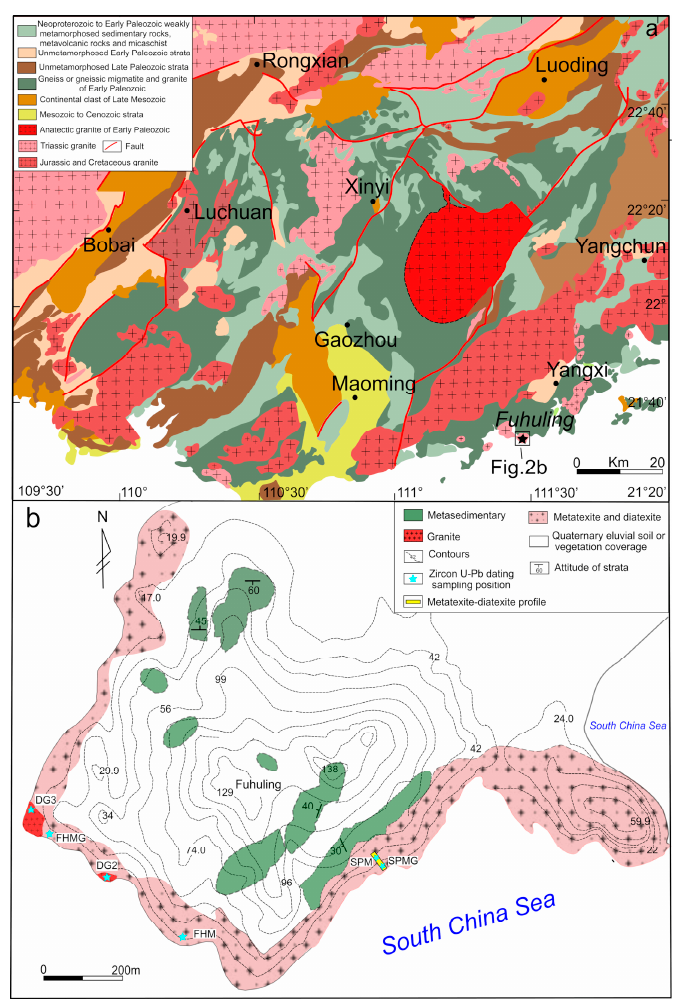
Figure 2. ( a ) Geological map of the Yunkai region (modified after [31,41]). ( b ) Geological map of Fuhuling with the metatexite–diatexite profile and sampling locations for U-Pb zircon geochronology.